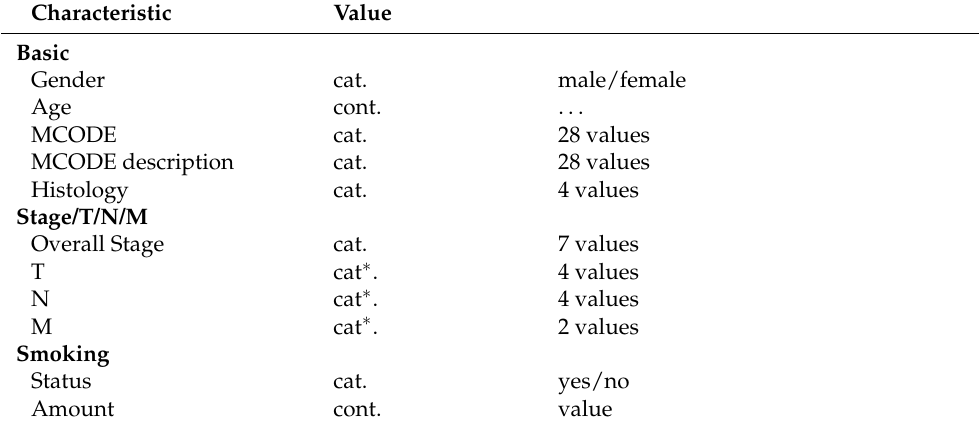
Table 2. Data fields